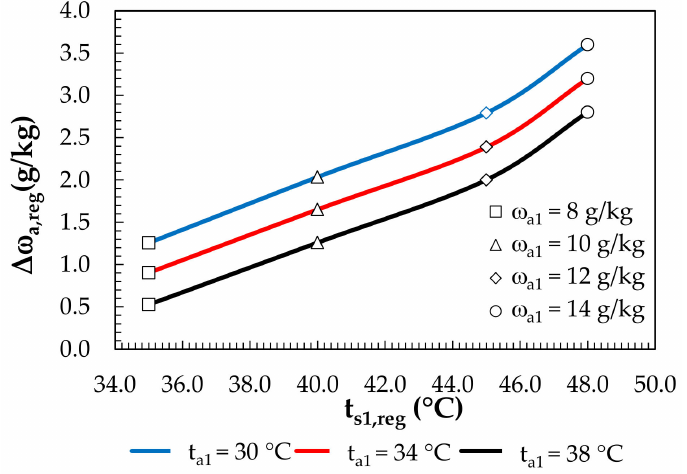
Figure 13. Effects of the solution temperature at the regenerator inlet and regeneration air parameters on the change in the humidity